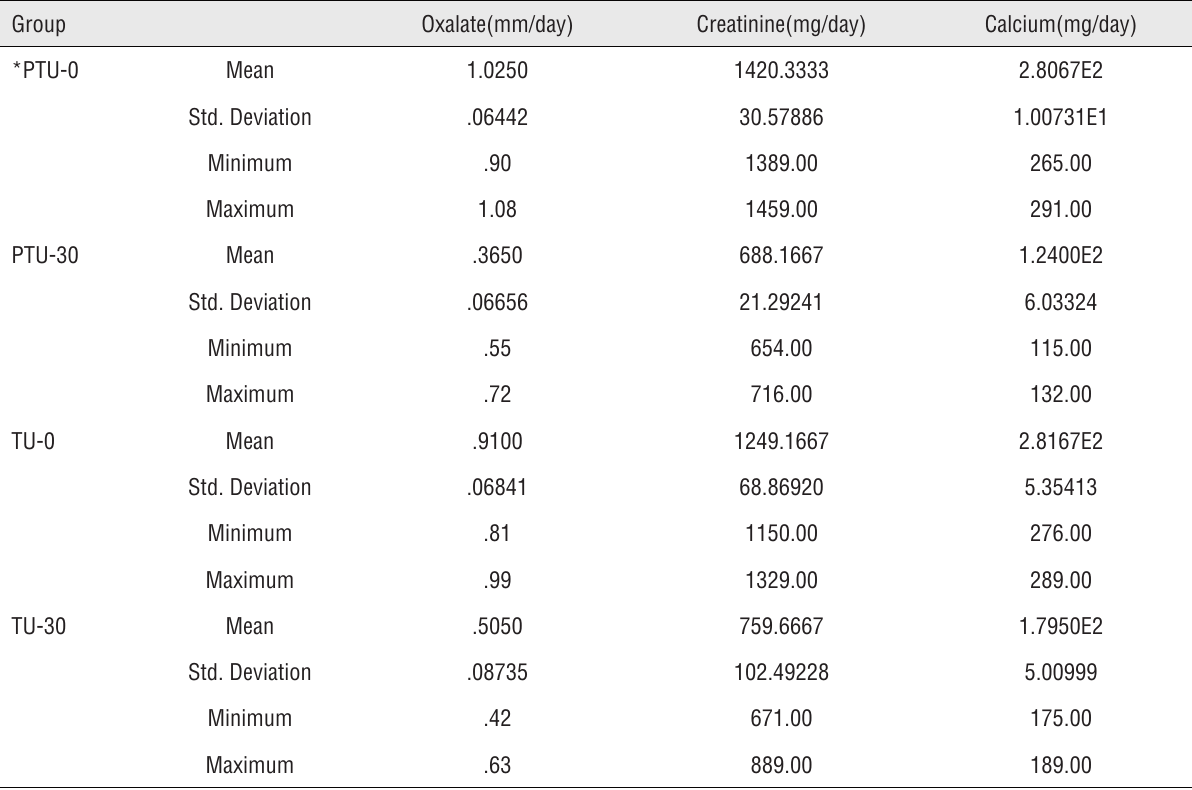
Table 2 - Urinary Oxalate, Calcium and Creatinine levels in Co-treatment groups in 0- and -30 days. Group